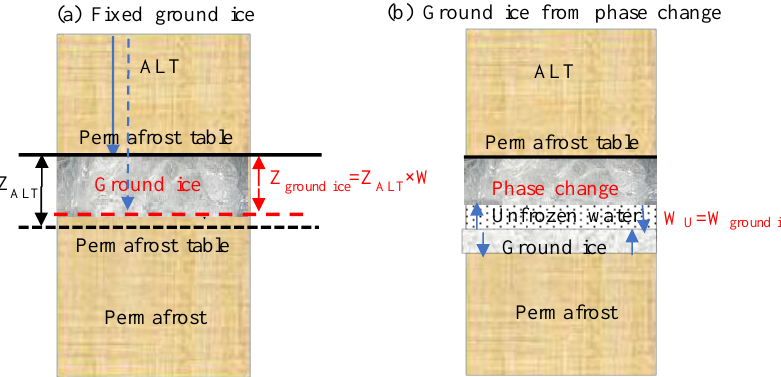
Figure 9. The influential mechanism of permafrost thawing on lake change. Z ALT is the increased thickness of the ALT; W is the soil water content at the permafrost table; Z ground ice is the melt thickness of the ground ice; W u is the increase in the unfrozen water content; W ground ice is the decrease in water content due to the phase change during the freezing–thawing process of active layer.